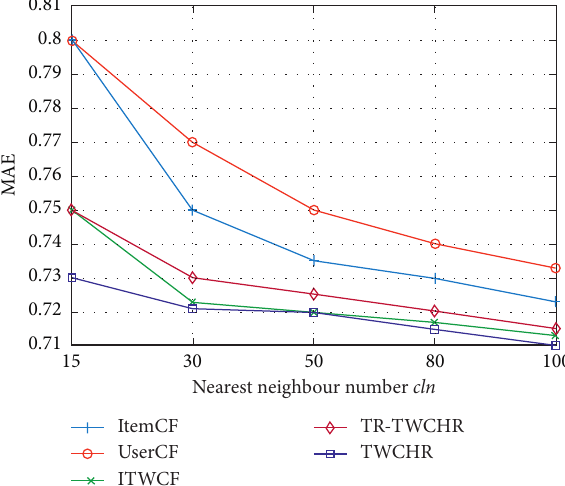
Figure 2: The influence of the information retention period on the recommendation algorithm.